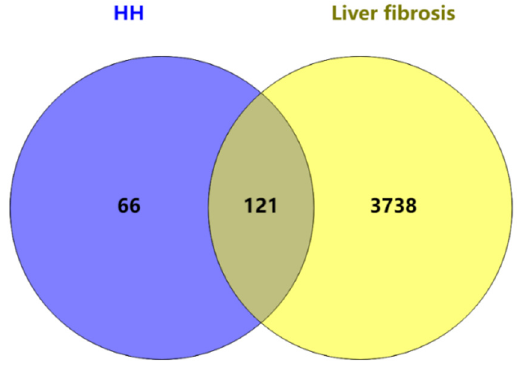
Figure 2. The Venn diagram of targets between HH and liver fibrosis.